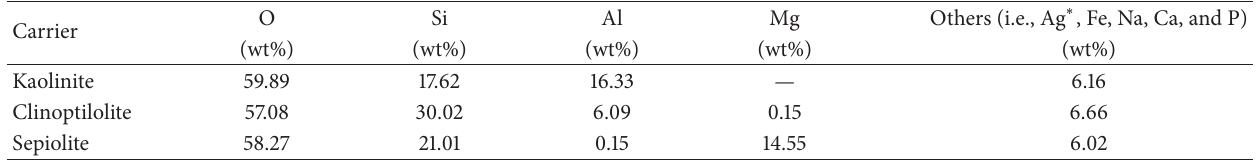
Table 3: EDX analysis results of the chemically treated clays.